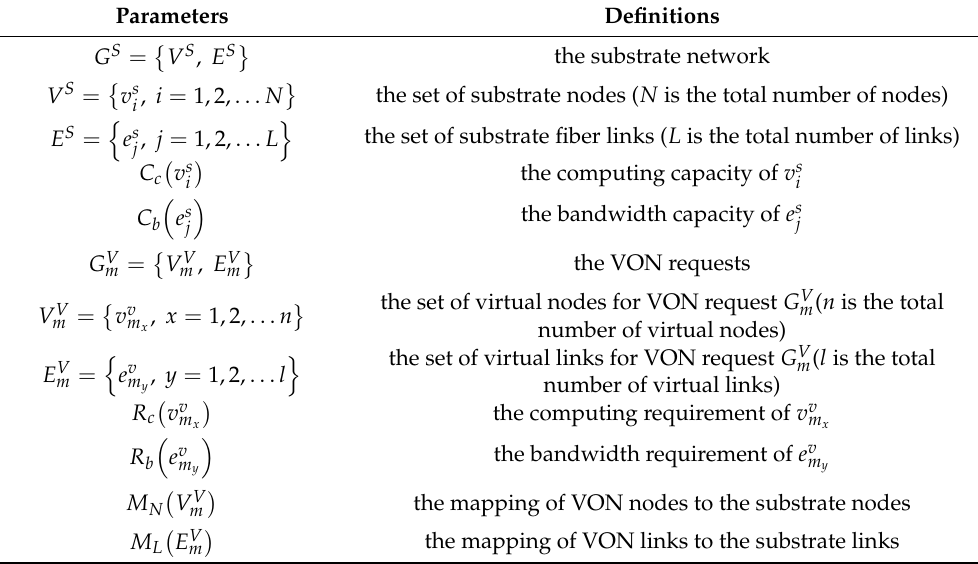
Table 1. Parameter